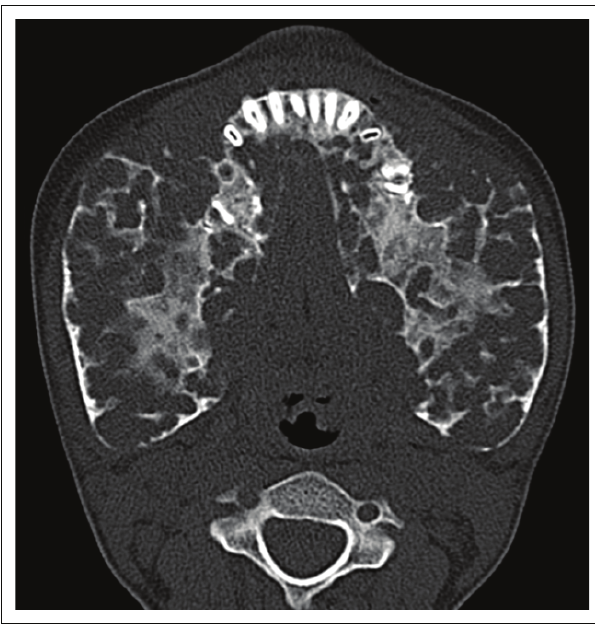
FIGURE 2: Axial computed tomography scan at the level of the mandible and inferior alveolar process, demonstrating diffuse, bilateral, expansile, multilocular lucencies in the mandible, with a soap-bubble appearance. Endosteal scalloping, cortical thinning and areas of cortical absence are also observed. Mild sclerosis and deformity of the inferior alveolar process are also demonstrated, and small submandibular and submental lymph nodes (not shown) are also present.